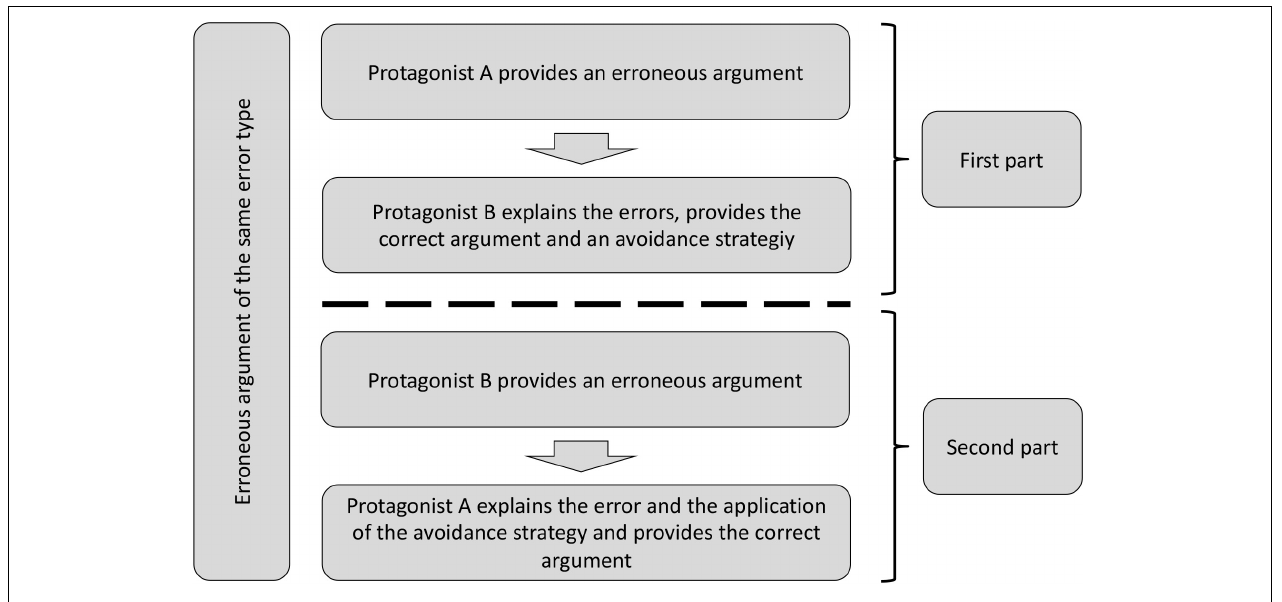
FIGURE 1 | Dialogue structure for a specific